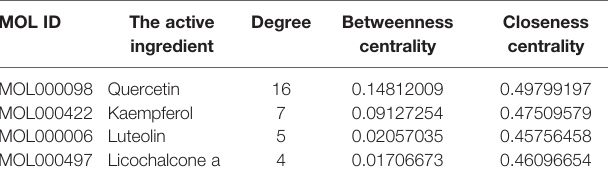
TABLE 1 | Network node characteristic parameters of main active ingredients of QYSLS. MOL ID The active ingredient